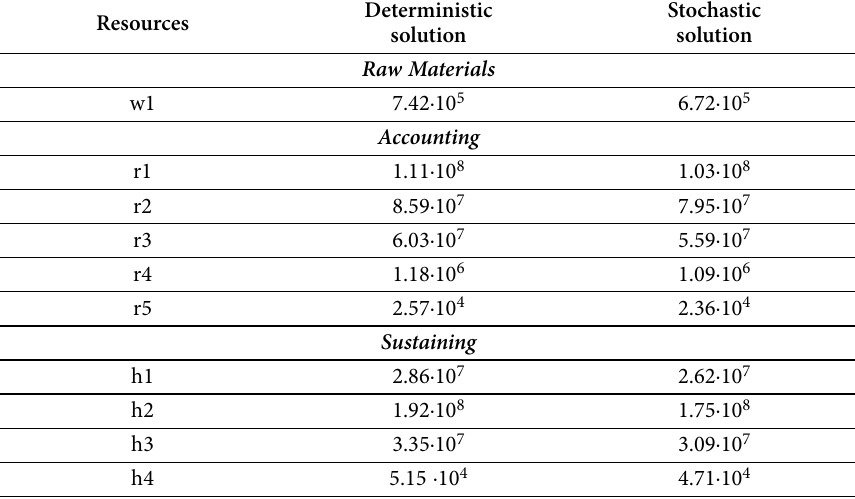
Table 8. Deterministic and stochastic solution values for the Crown Prosecution Service model Resources